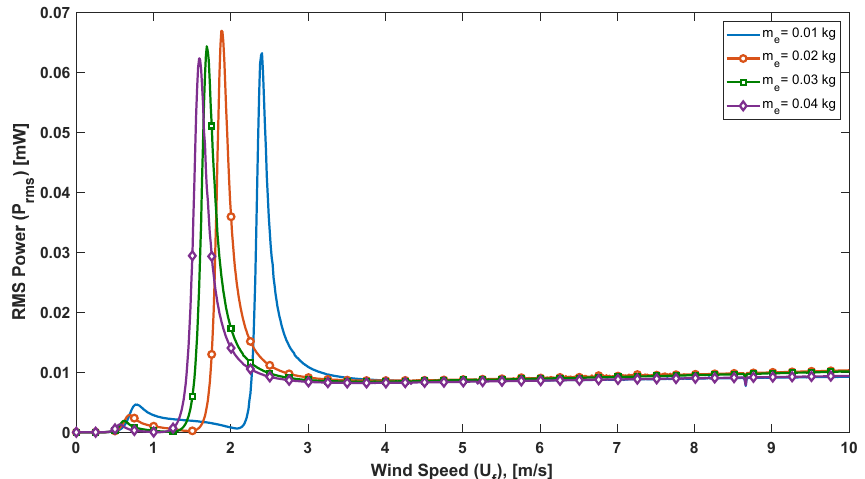
Figure 8. The effect of m e on the harvester power and bandwidth. The mass changes from 0.01 kg to 0.04 kg.